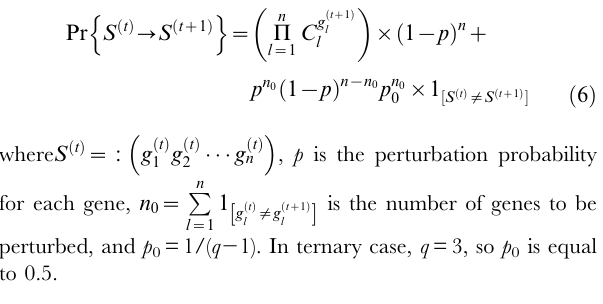
Figure S1 The identification of conserved and divergent co- expression gene clusters from human and mouse ESC-EB data for the WNT pathway. The figure legends are the same as for Figure 1. Figure S2 The identification of conserved and divergent co- expression gene clusters from human and mouse ESC-EB data for